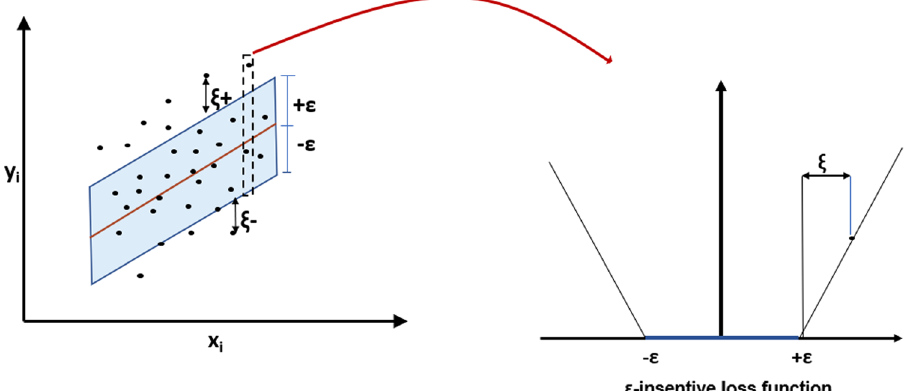
Fig. 4 Schematic presentation of the support vector machine